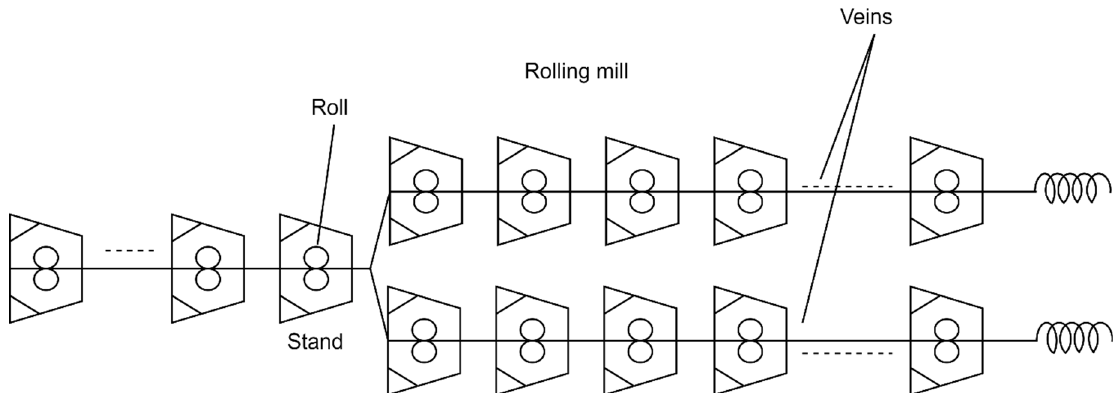
Figure 1. Schema of the wire rod rolling mill .